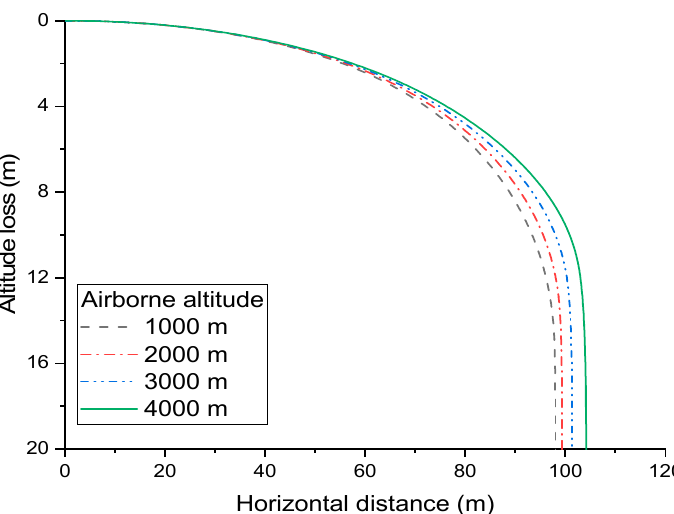
Figure 6. Flight trajectories of parachute systems at different altitudes. The flight velocity changes at different deplaning velocities are shown in Figure 7. With the increase in the deplaning velocities, the deceleration effect of the parachute is more significant as the drag increases with the square of velocities. The velocity difference between parachute systems decreases before the parachute inflates. As the parachute fully inflates, the order of parachute velocities reverses after ~1.0 s. This is because both deploy- ment time and inflation time decrease due to the larger inertia. Compared with the system deplaning at 60 m/s, the deployment time and inflation time of the system deplaning at 120 m/s reduce by 53.3% and 42.7%, respectively. Therefore, the larger the deplaning ve- locities are, the earlier the parachute systems reach a steady state. The flight trajectories at different deplaning velocities are shown in Figure 8. The increase in the deplaning velocity directly increases the horizontal distance of the motion, e.g., the parachute systems de- planing at 120 m/s travel 15.9% 6further. Furthermore, the altitude loss during the para- chute inflation reduces, as the parachute inflation time reduces. This explains the sharp “brake” at 120 m/s in the flight trajectories in Figure 8.